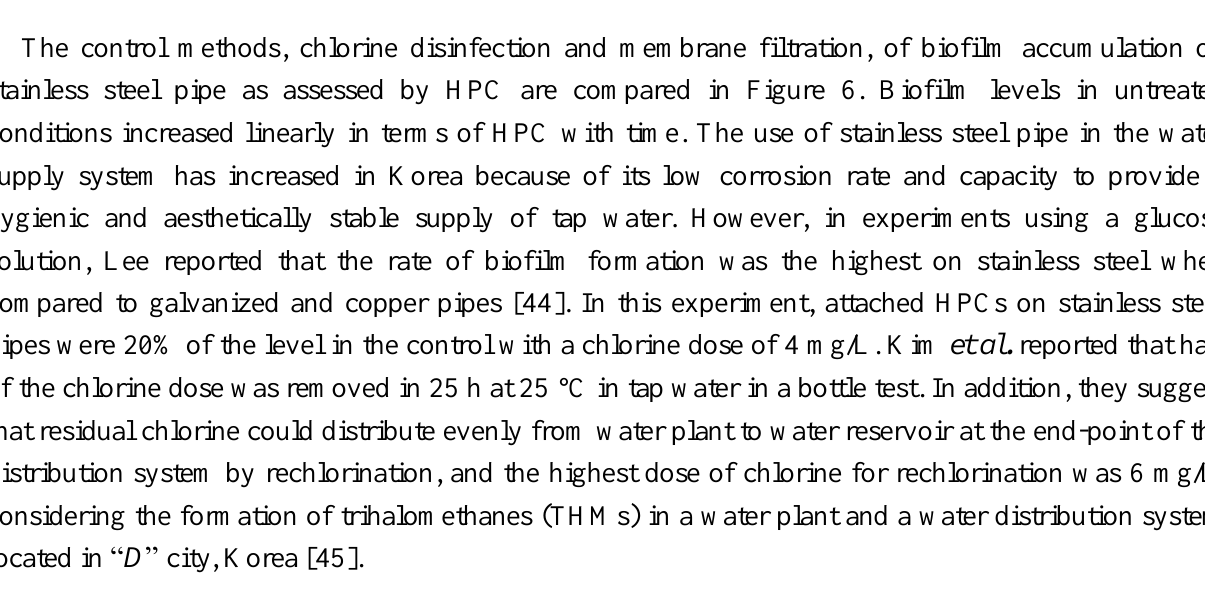
Figure 6. Comparison of biofilm control methods in stainless steel